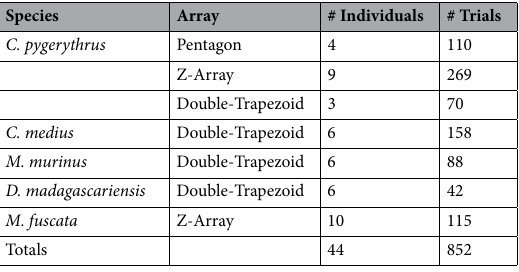
Table 2. Individuals and trial sample size included in the